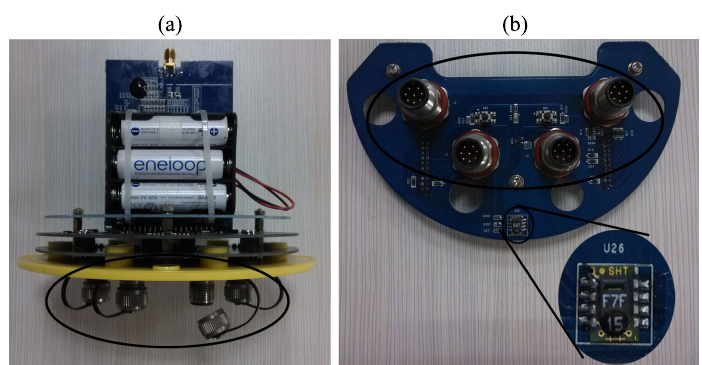
Figure 4. Sensing nodes and the deployment at Nanjing University of Information Science and Technology (NUIST). ( a ) The circuit board inside of the sensing node; ( b ) the bottom circuit board containing the on-board sensor SHT15 and providing interface circuits for external sensors.